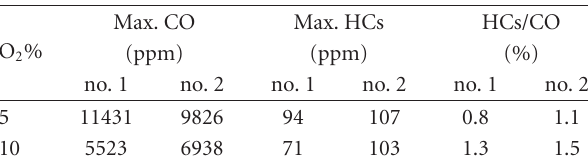
Figure 14: Comparisons of coal and coal water mixture on HCs gas generation by CO 2 injection. Table 3: Comparisons of flue gases between Coal no. 1 and Coal no. 2 for laser power of